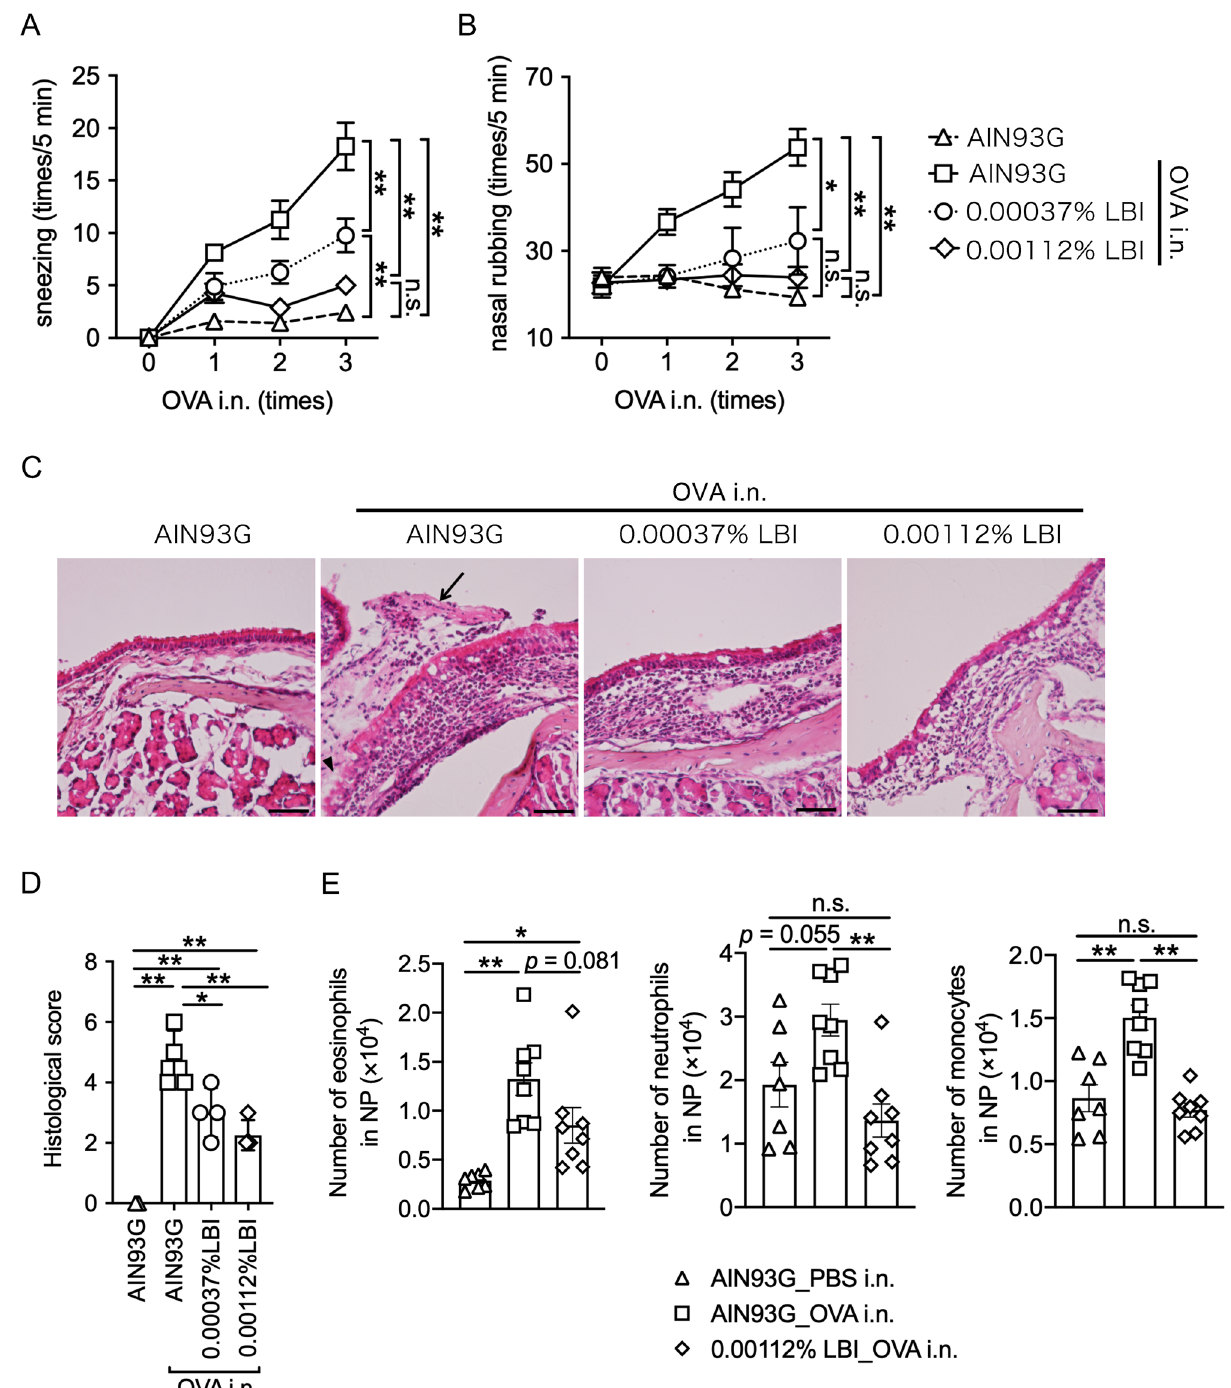
Figure 1. LBI supplementation attenuates OVA-induced allergic symptoms and histological damage in mice. ( A – E ) Allergic rhinitis was induced by OVA exposure in pre-sensitized male C57BL/6J mice. Sneezing ( A ) and nasal rubbing ( B ) were counted for 5 min immediately after the administration of intranasal PBS or OVA exposure. The data were pooled from two different experiments and are shown as the means ± SEM ( n = 7, 8, 8, 8). ( C ) Representative histological images of nasal mucosa stained with hematoxylin and eosin ( C ). ( D ) Assessment of histological damage using histological damage scoring ( D ). Data are presented as the means ± SD ( n = 3, 4, 4, 4). Scale bar, 50 μm. ( E ) The number of Siglec-F + CD11b + CD45 + eosinophils, Siglec-F - CD11b + CD45 + Ly6G + Ly6C - neutrophils, and Siglec-F - CD11b + CD45 + Ly6G - Ly6C + monocytes in the nasal passage. The data were pooled from two different experiments and shown as the means ± SEM ( n = 7, 8, 8). Two-way analysis of variance ANOVA test with Tukey’s multiple comparisons test ( A , B ). One-way ANOVA test with Tukey’s multiple comparisons test ( D – E ). n.s.: not significant; * p < 0.05, ** p < 0.01. OVA, ovalbumin; PBS, phosphate-buffered saline; NP, nasal